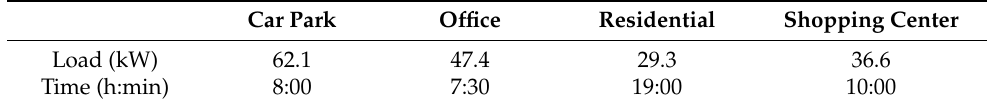
Table 2. The average peak load of the days and the times of occurrence.